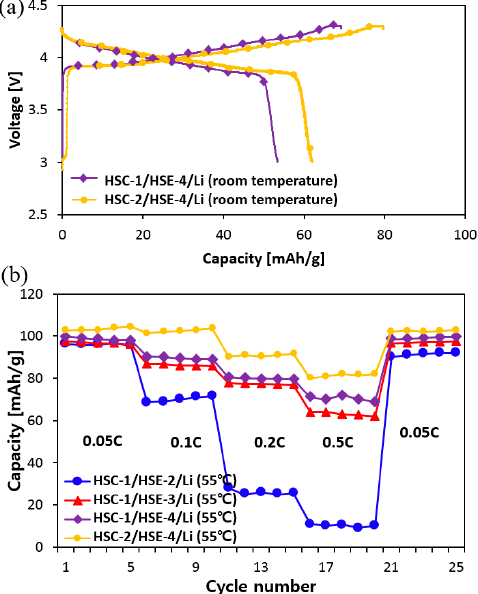
Figure 7. ( a ) 1st charge-discharge profiles of HSC-1/HSE-4/Li cell and HSC-2/HSE-4/Li cell at room temperature. ( b ) C-rate performance of HSC-1/HSE-2, HSE-3, HSE-4/Li cells and HSC-2/HSE-4/Li cell at 55 ◦